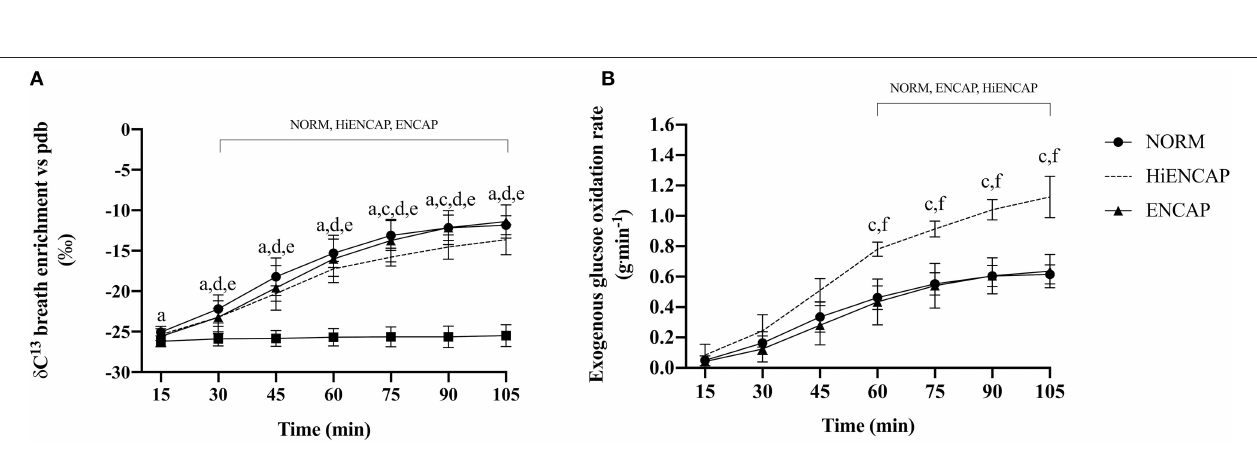
FIGURE 2 | Breath 13 CO 2 enrichment vs. PDB (A) and ExGluc oxidation (B) . a = significant difference between NORM and WAT, c = significant difference between NORM and HiENCAP, d = significant difference between WAT and ENCAP, e = significant difference between WAT and HiENCAP, and f = significant difference between ENCAP and HiENCAP. Time points that are significantly different from values at 15min are encompassed by a square bracket. n = 8. Values are mean ± SD.